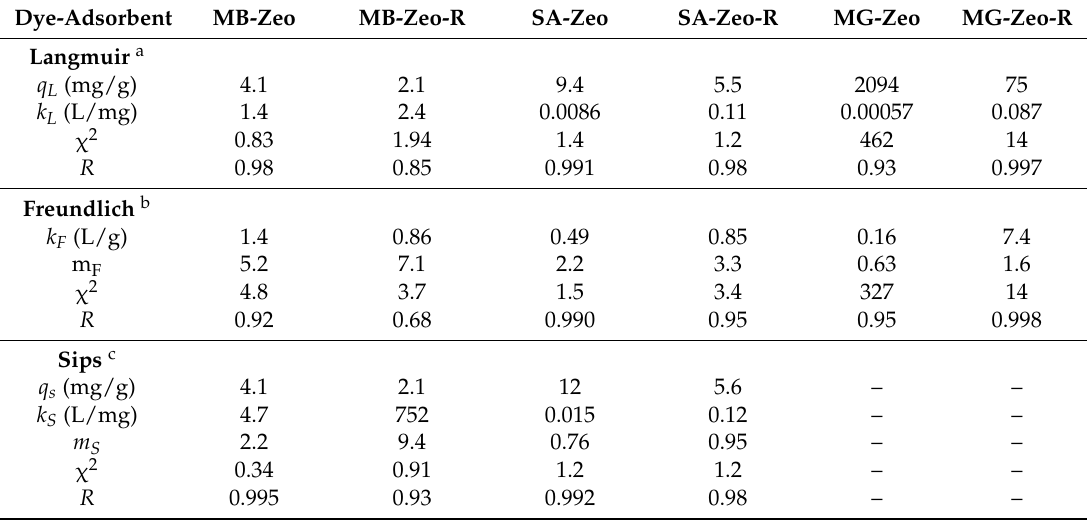
Table 5. Langmuir, Freundlich, and Sips equation parameters for the adsorption of MB, SA, and MG onto Zeo and